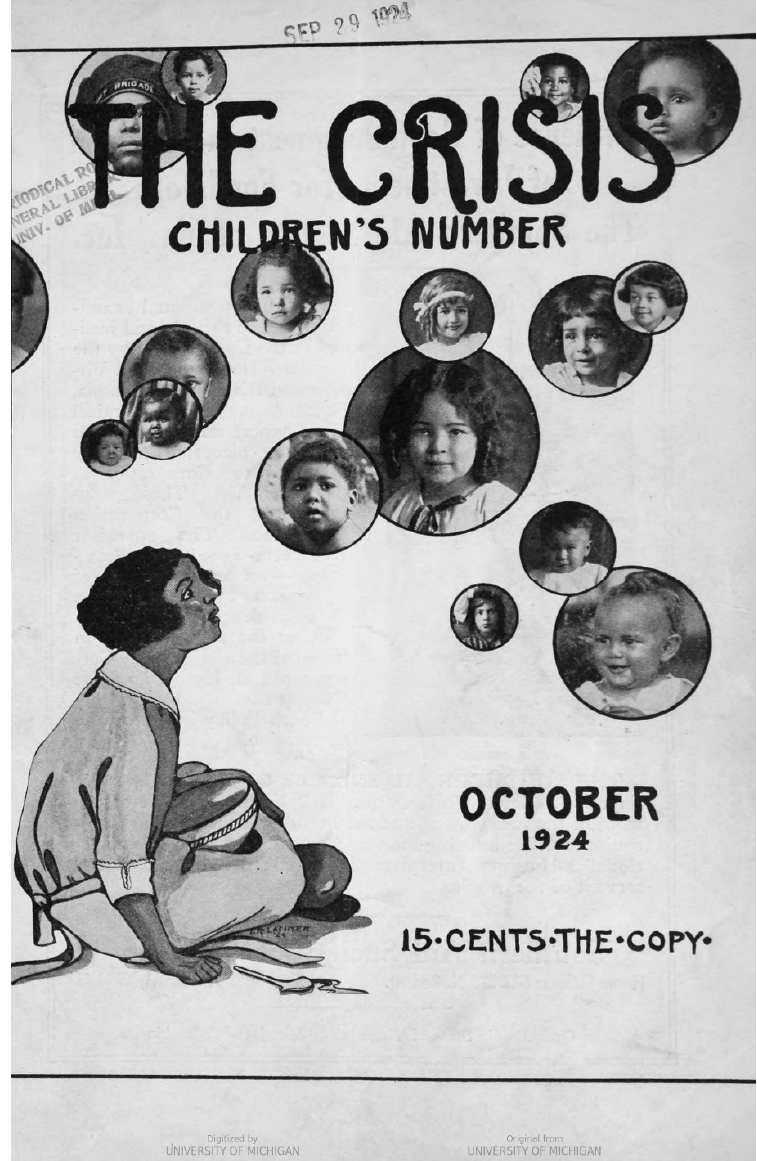
Figure 4. The Crisis , October 1924. Three poems—Jessie Fauset’s “Oriflamme”, Anita Scott Coleman’s “Black Baby”,